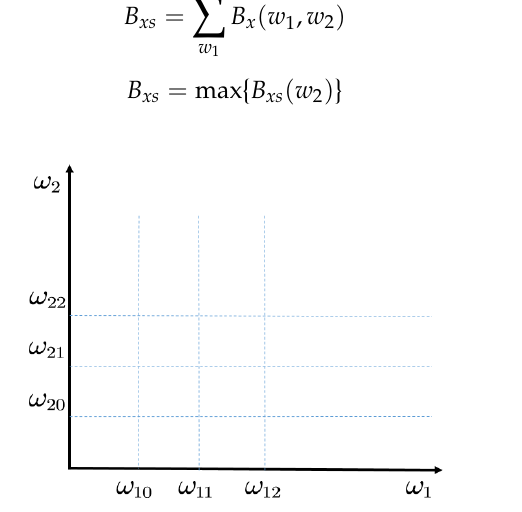
Figure 1. The formation of bispectral peaks on the carrier frequency and modulation frequency plane.